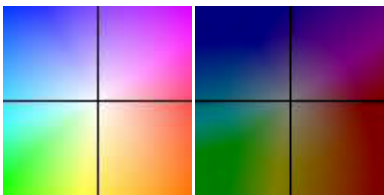
Figure 13. Color coding for occupancy grid speed vectors (full and half occupancy). The hue represents the direction (i.e., red means the obstacle cell is moving to the right), the saturation represents the speed magnitude, and the intensity represents the occupancy probability of the grid [16]. © 2011 IEEE. Reprinted, with permission, from IEEE Transactions on Intelligent Transportation Systems, Vol. 12, No. 4.